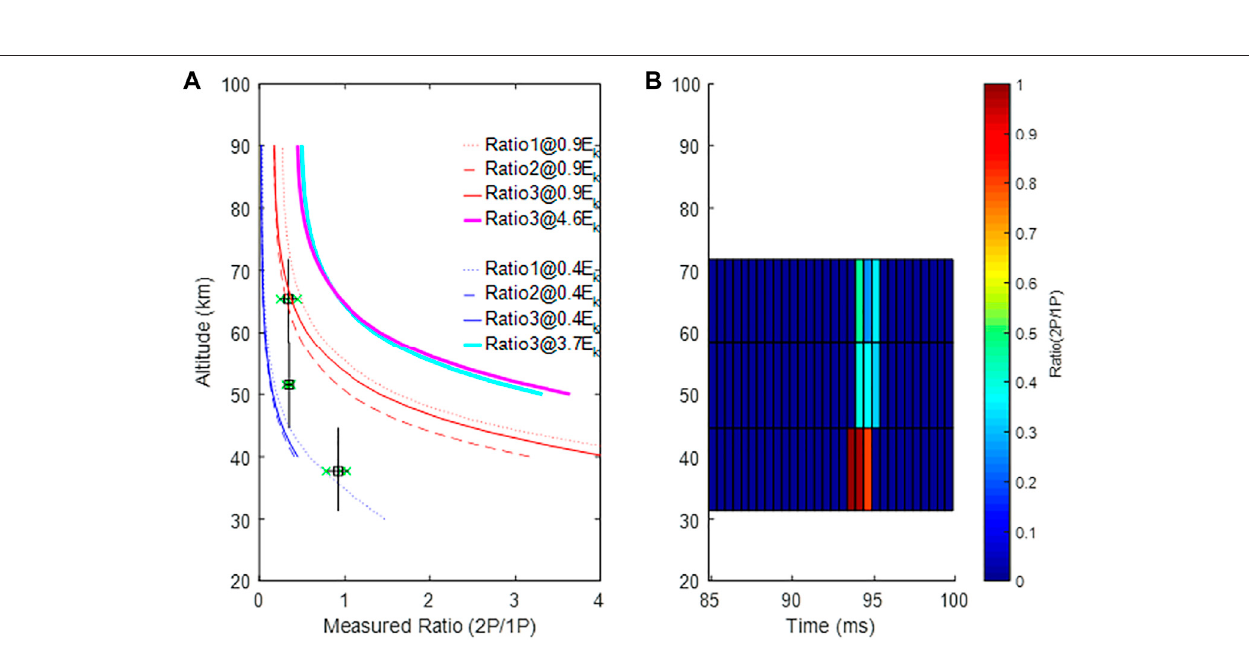
emission ratio 2P/1P using numerical results on sprite streamers (Celestin and Pasko, 2010; Pérez-Invernón et al., 2018). AP- measured ratios in sprite halo events are consistent with predicted ratios for streamer head electric fi elds of 3.7 E k and 4.6 E k in Figure 8A . Most carrot sprite events initialized at altitudes 67.4 ± 7.6 km with lower estimated electric fi eld 1 ∼ 3 or 4 E k . Below